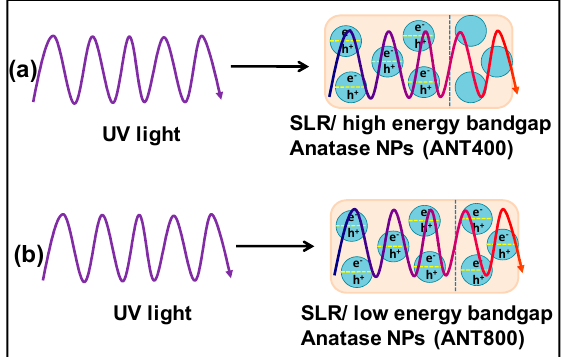
Figure 2. The key mechanism of photopolymerization process assisted by UV light penetration through the ( a ) stereolithography resin (SLR)/high energy bandgap semiconducting anatase nanoparticles (NPs) (ANT400) and ( b ) SLR/low energy bandgap semiconducting anatase NPs (ANT800). The energy/intensity of UV rays reduced (the violet color lines indicate higher intensity and red color lines indicates lower intensity) when it underwent deep penetration through the resin composites .